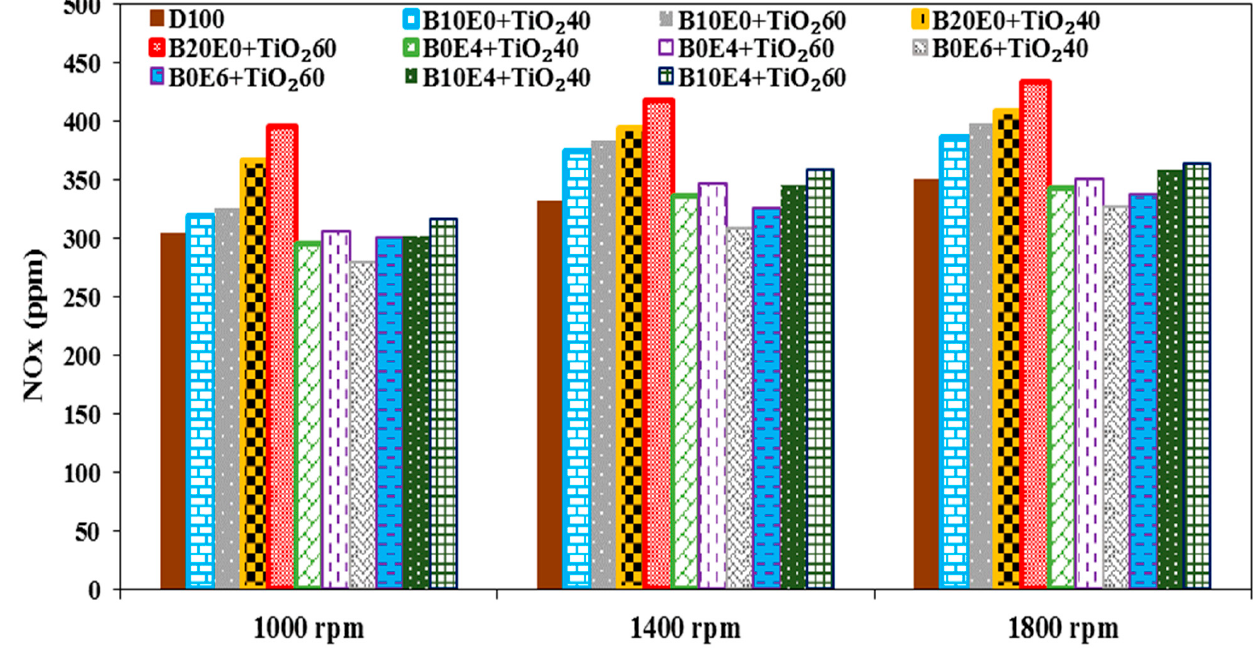
Figure 10. Variation of NO x for diesel/ethanol/biodiesel blends at TiO 2 = 40, 60 ppm, and various engine speeds.